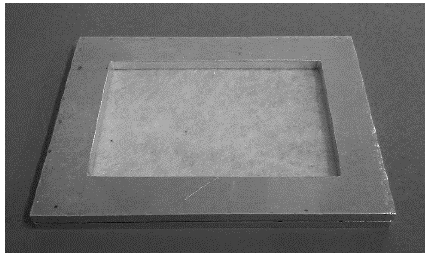
Figure 8. Aluminum frame for the multidirectional thermal stabilization process with PLLAGLTMC nonwoven fabric.